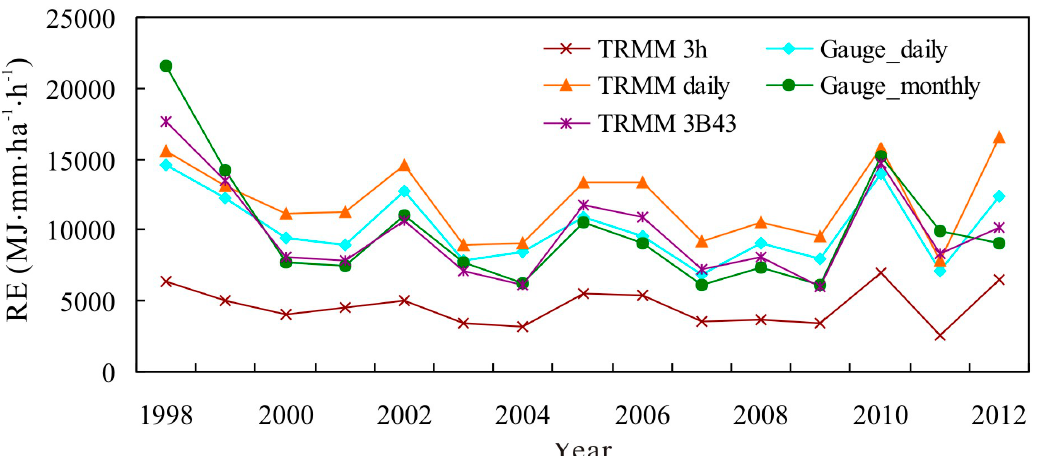
Figure 6. Comparison of annual rainfall erosivity estimated by rainfall data with different temporal resolutions.